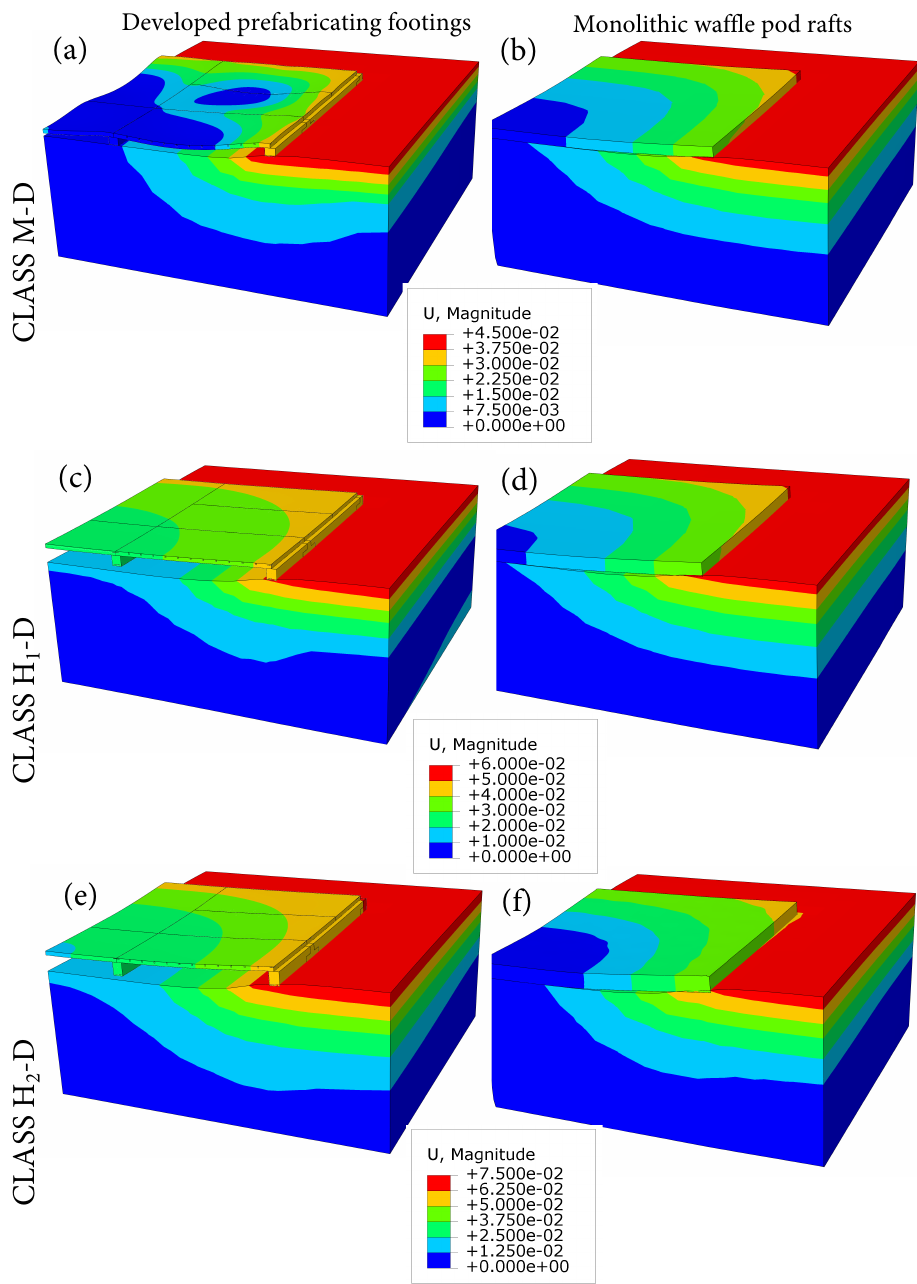
Figure 6. Comparison of swelling soil movement and footing deformation between the developed prefabricated footing systems and waffle rafts for ( a , b ) Class M-D soil, ( c , d ) Class H 1 -D soil, and ( e , f ) Class H 2 -D soil. Values of displacements are in